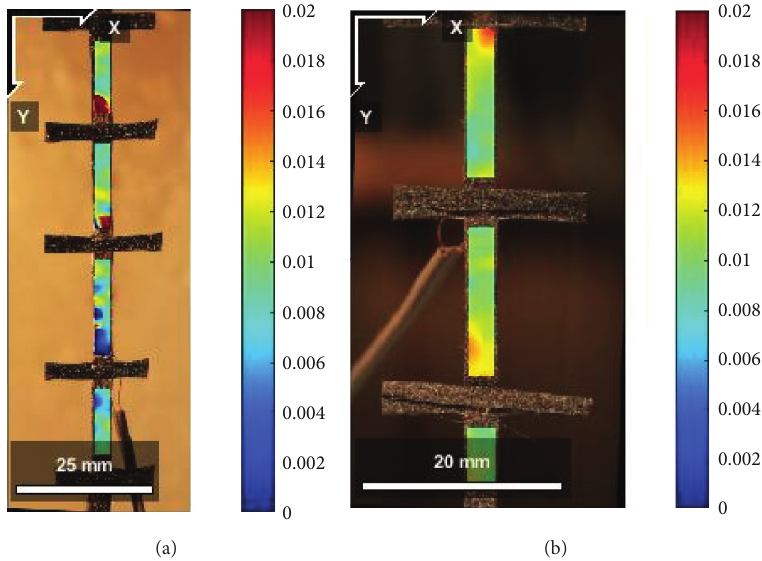
Figure 9: Vertical strain result of H-CFRP grids at their ultimate load. (a) H-CFRP-1. (b) H-CFRP-2.